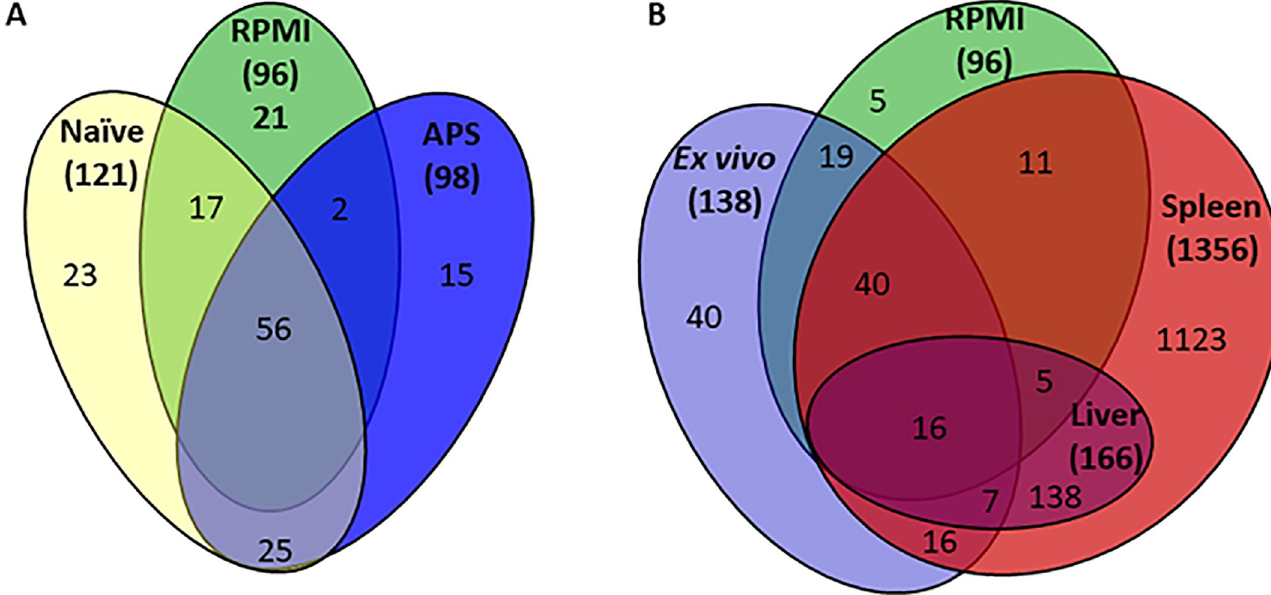
Fig 1. Distribution of Tn-Seq candidate fitness factors in vitro compared to in vivo. (A) A Venn diagram illustrating the number of overlapping candidate P. mirabilis fitness factors among three growth conditions: 1) RPMI medium alone (RPMI), 2) RPMI medium with 50% heat-inactivated na ï ve mouse serum (Na ï ve), and 3) RPMI with 50% heat-inactivated acute-phase serum (APS). (B) A Venn diagram depicts the number of overlapping candidate P. mirabilis fitness factors among four growth conditions: 1) RPMI medium with either 50% heat-inactivated na ï ve mouse serum or 50% heat-inactivated acute-phase serum (Ex vivo), 2) RPMI medium alone, 3) mouse spleen, and 4) mouse liver. Numbers in parentheses represent the total number of candidate fitness factors for each group.